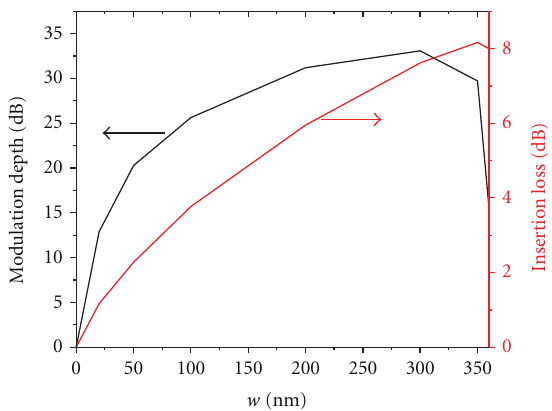
Figure 7: Modulation depth T ( κ = 1) /T ( κ = 0) (black curve) and insertion loss (red curve) of the side-coupled-cavity switch (Figure 5(a)) as a function of the stub width w . For each stub width w , the stub length L is equal to the first resonant length of the cavity. All other parameters are as in Figure